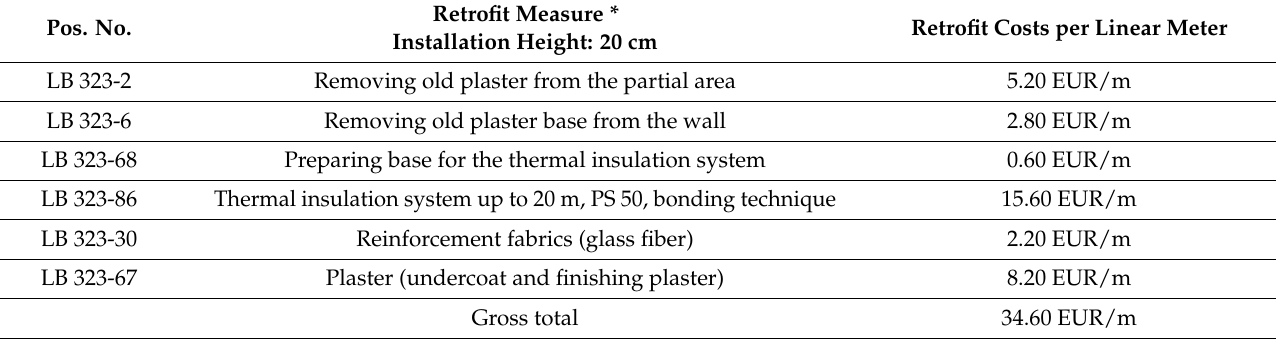
Table A10. Retrofit components and costs of the thermal bridge retrofit of a connection between a wall and a rooftop [38,39]. Pos. No.